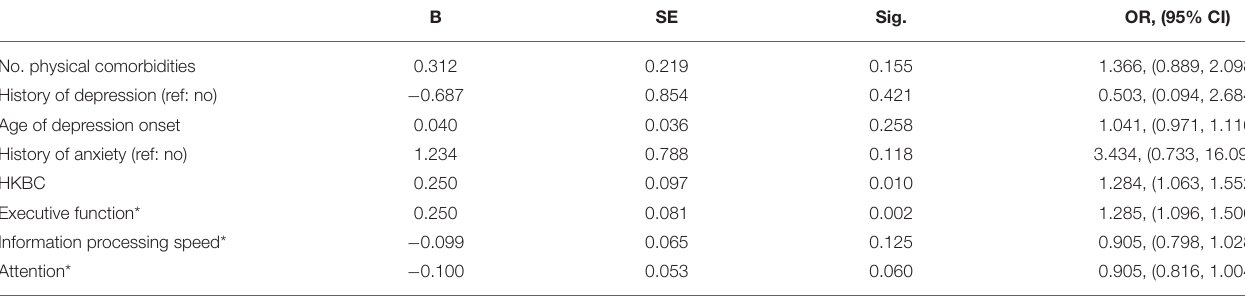
Binary logistic regression was performed to investigate the association between class membership and the following characteristics with significant differences between groups: number of physical comorbidities, history of depression and anxiety, age of depression onset, HKBC score, executive function, information processing speed, and attention. * , Multiplied by 10 concerning the relatively small range of z